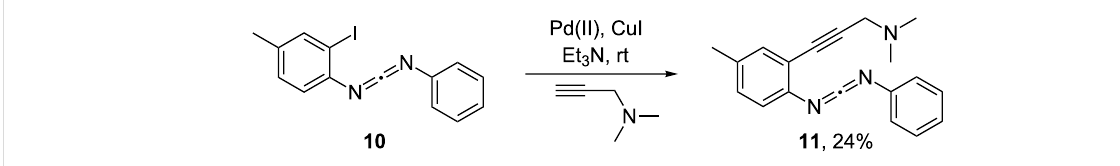
Scheme 3: Synthesis of enyne-carbodiimide 11